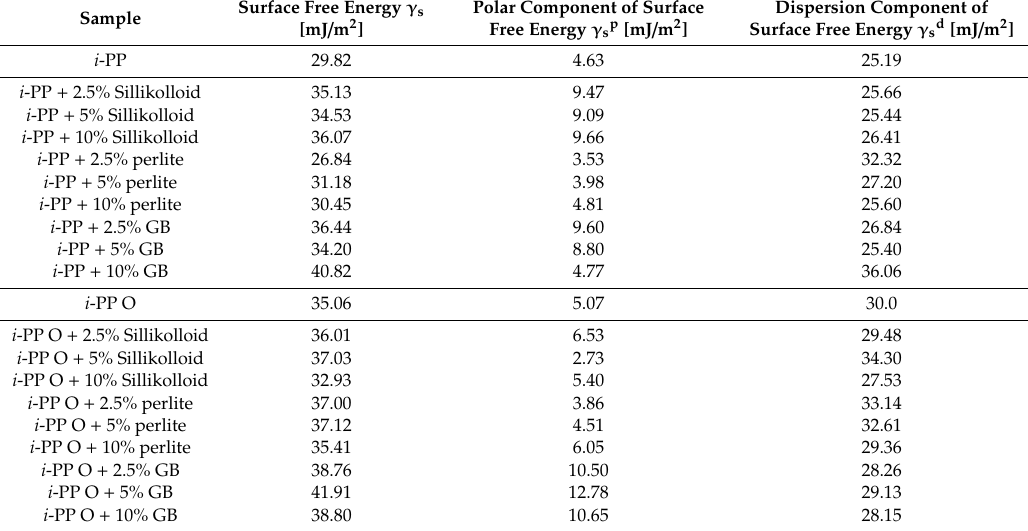
Table 3. Surface free energy and its components for 1-month-irradiated unoriented and oriented (O) isotactic polypropylene ( i -PP) films with di ff erent content of Sillikolloid, perlite, and glass beads